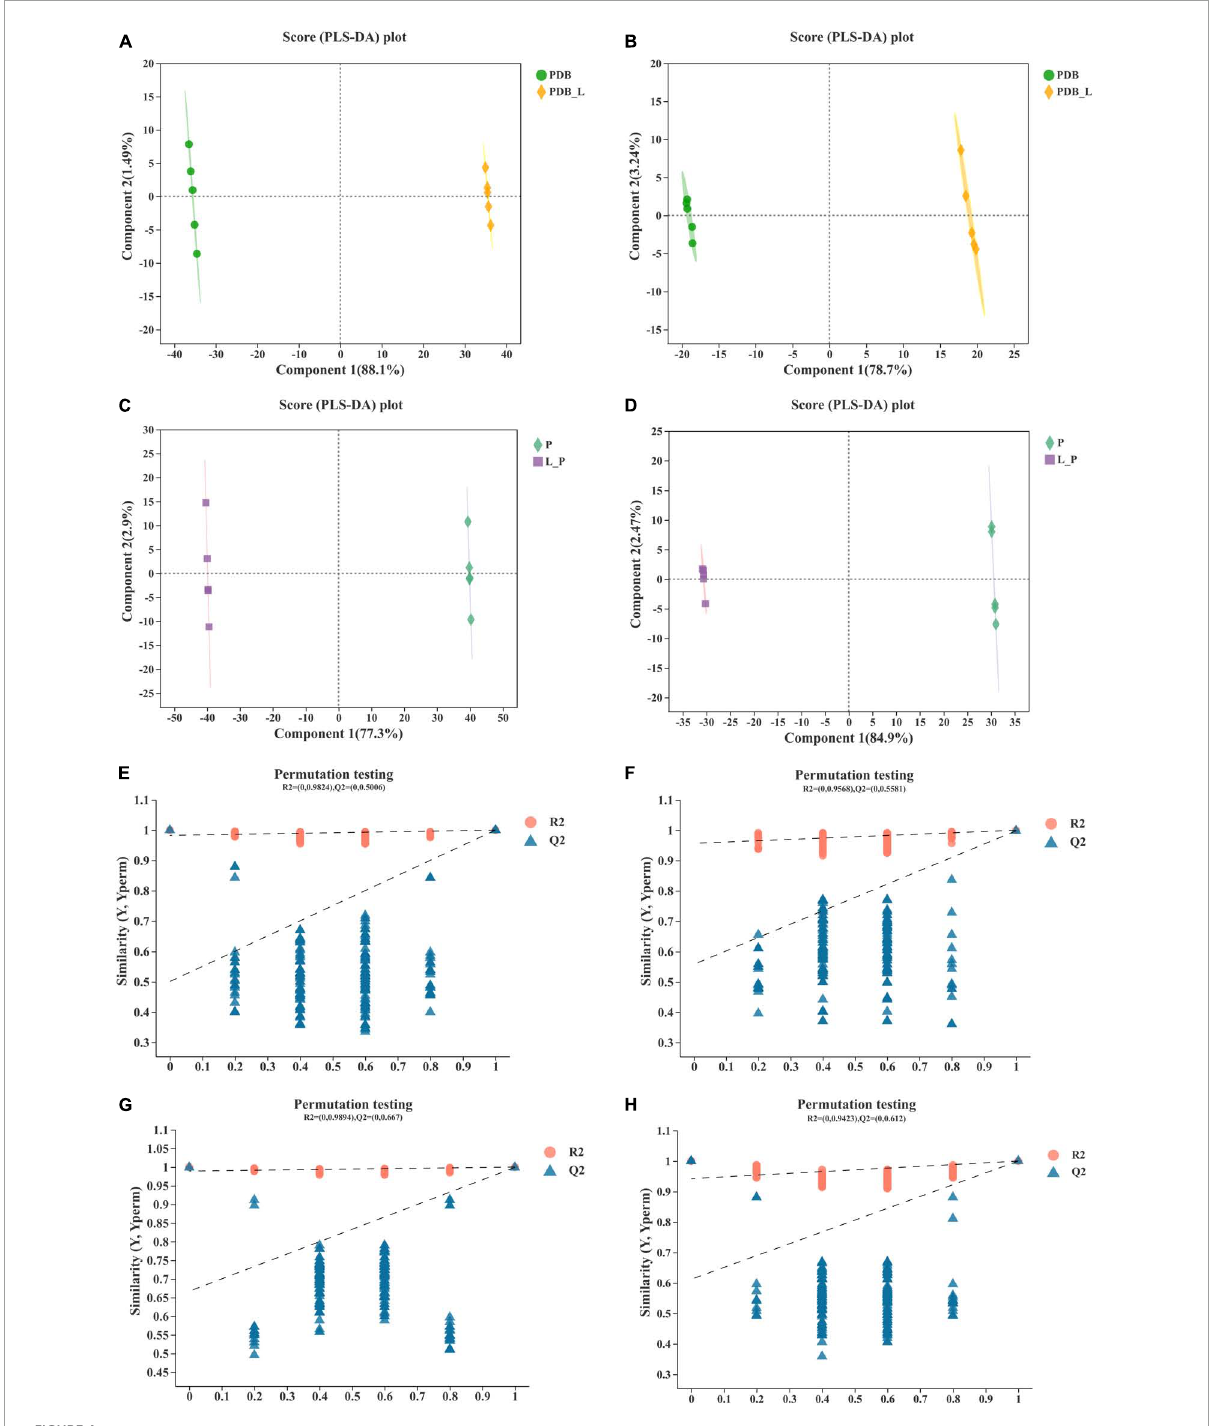
FIGURE4 Validation of partial least squares discriminant analysis (PLS-DA) models. Pairwise comparation of among PDB, PDB_L, L_P, and P in positive ion mode (A,C,E,G) and negative ion mode (B,D,F,H) .